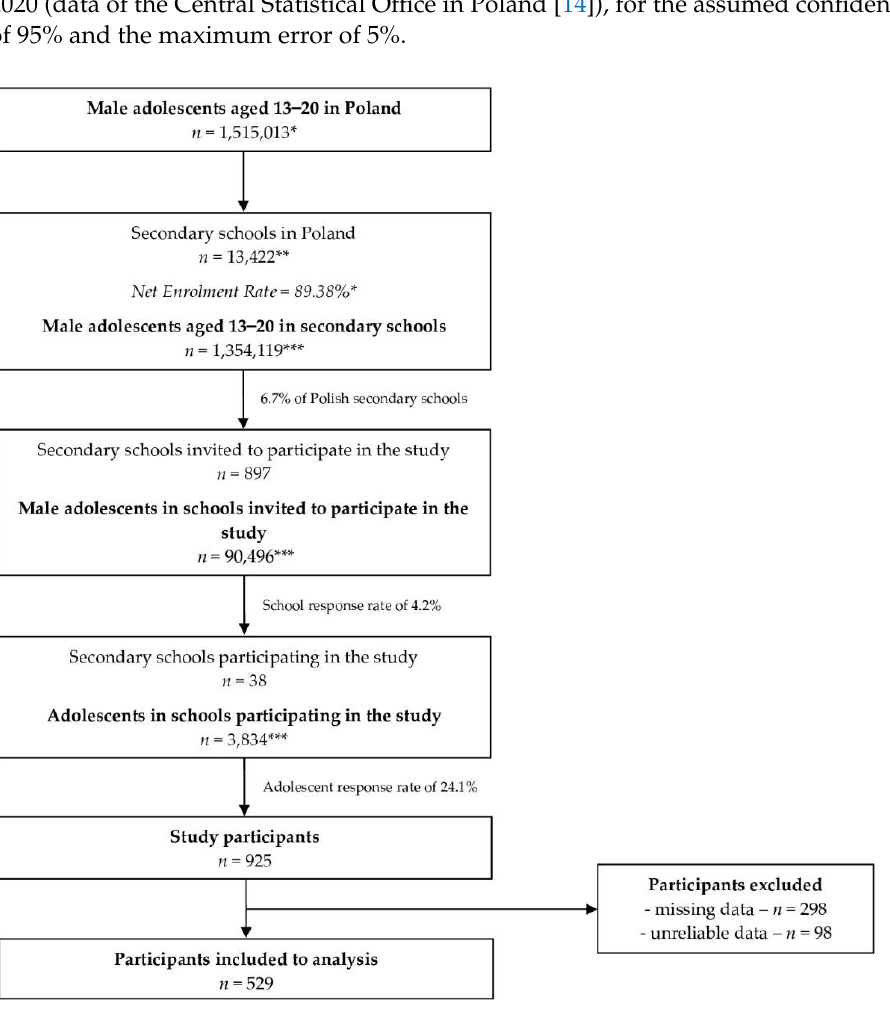
Figure 1. The detailed sampling and recruitment procedure; * data of the Central Statistical Office in Poland [12,14]; ** data of the Polish Ministry of National Education [15]; *** calculated based on available